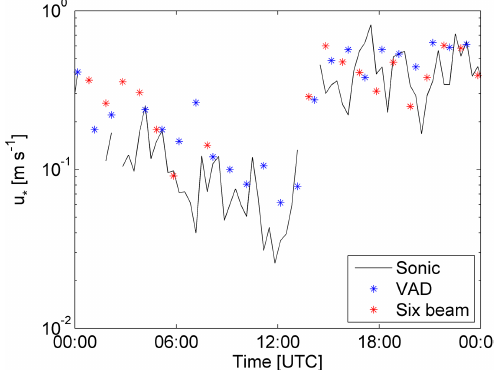
Figure 11. Sample time series of measured u ∗ on 30 May 2015 at